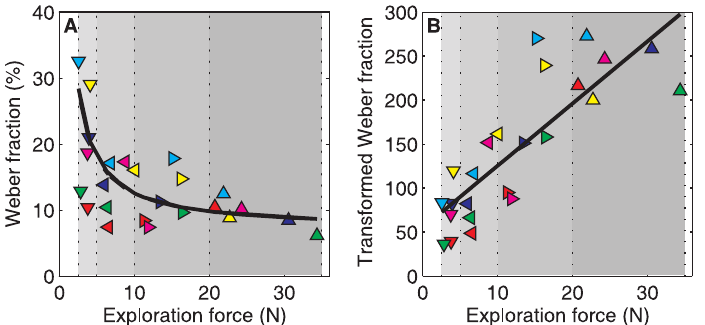
Figure 6. Relationship between force and Weber fraction. A: Relationship between the exploration force and the Weber fraction. Colored symbols indicate the individual participants (same color coding as in Figure 5). The grey shaded areas indicate the four force categories F1 , F2 , F3 , and F4 . The black solid curve corresponds to the best-fit linear regression line shown in panel B. B: Relationship between the exploration force and the transformed Weber fraction (i.e., the product of the exploration force and the Weber fraction) (details as in A). The black solid line represents the best- fit linear regression line.